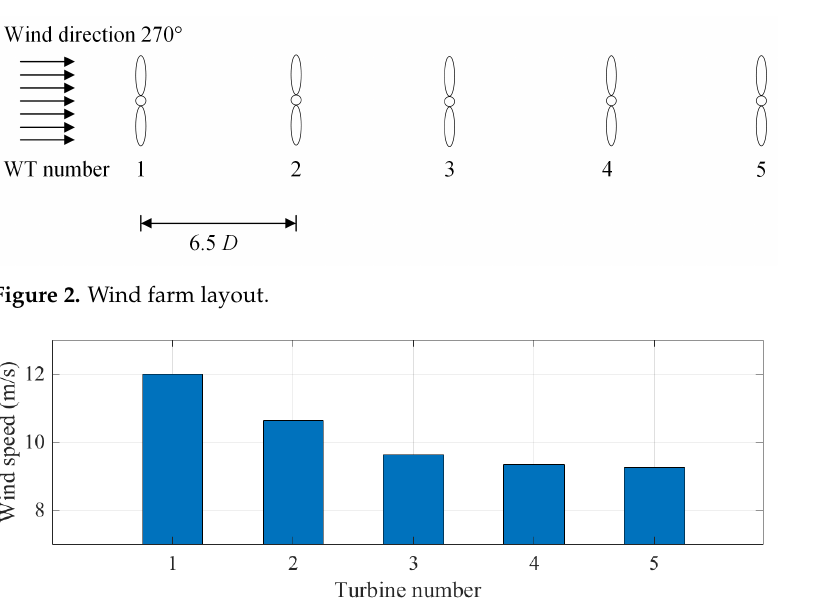
Figure 3. Wind speed